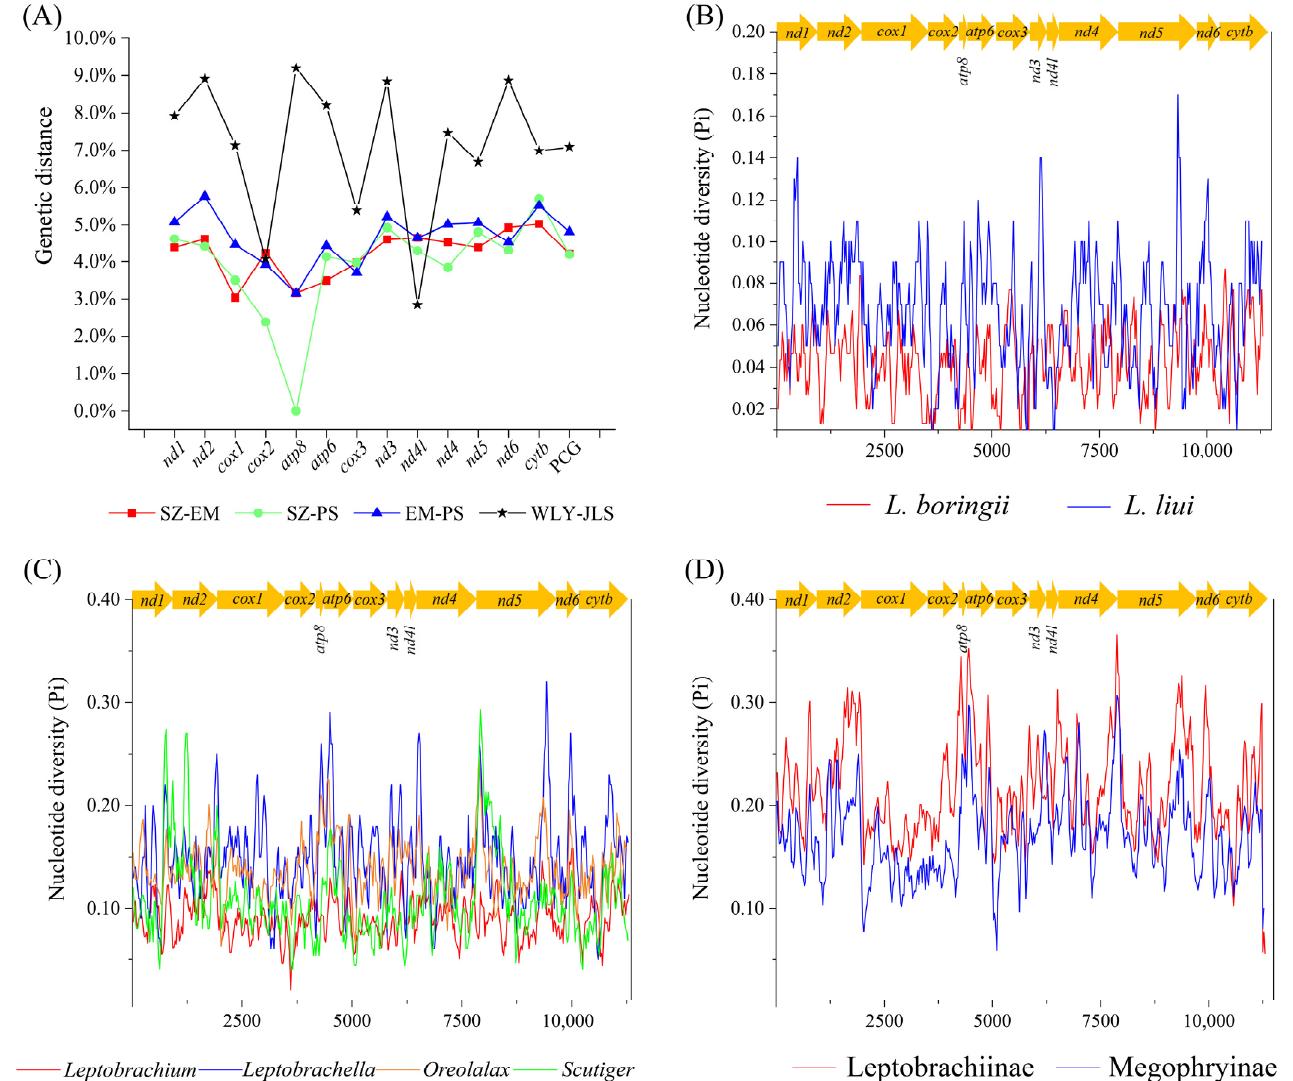
Figure 5. ( A ) Genetic distances between different populations of L. boringii and L. liui , and nucleotide diversity (Pi) under sliding window analysis of ( B ) three populations of L. boringii and two populations of L. liui , ( C ) four groups of Clade II, and ( D ) two clades of Megophryidae.